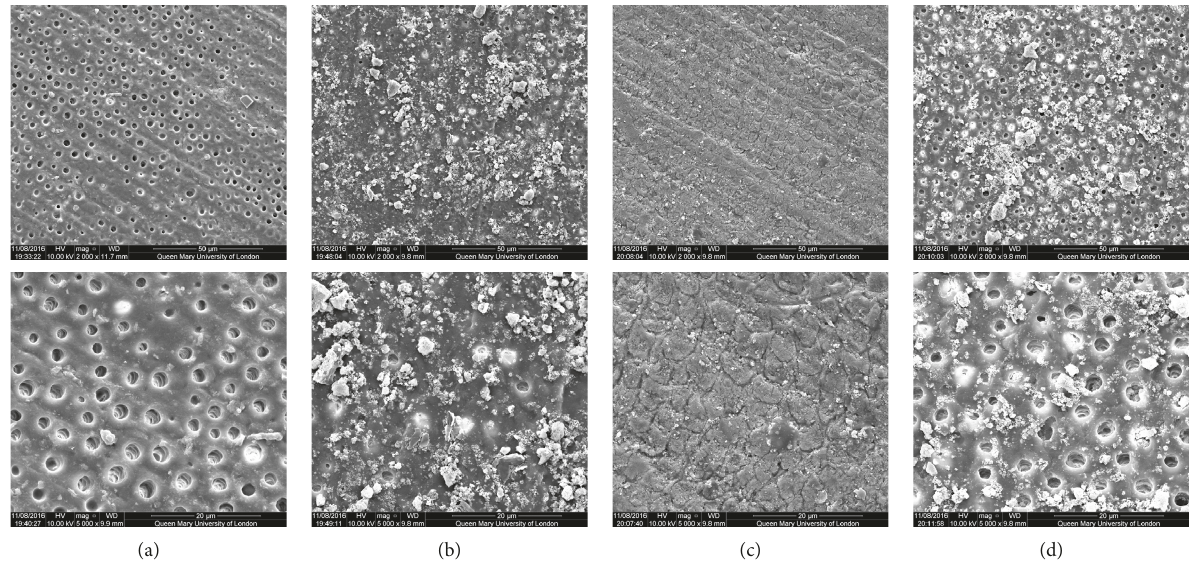
Figure 2: SEM images of the dentine surface morphology in disc 2 treated with a mixed glass-based toothpaste at 2000x (top) and 5000x (bottom) magnifications. (a) Control; (b) after brushing with a bioactive glass-based toothpaste; (c) after brushing with a bioactive glass- based toothpaste+artificial saliva immersion for 1 hour; (d) after brushing with a bioactive glass-based toothpaste+acid challenge with 6% citric acid.